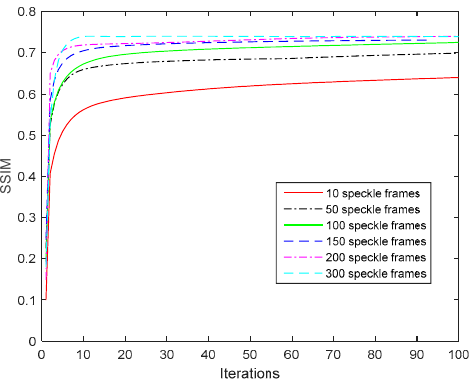
Figure 10. Quantitative reconstruction results of ptychographic imaging correlography with various speckle frames.